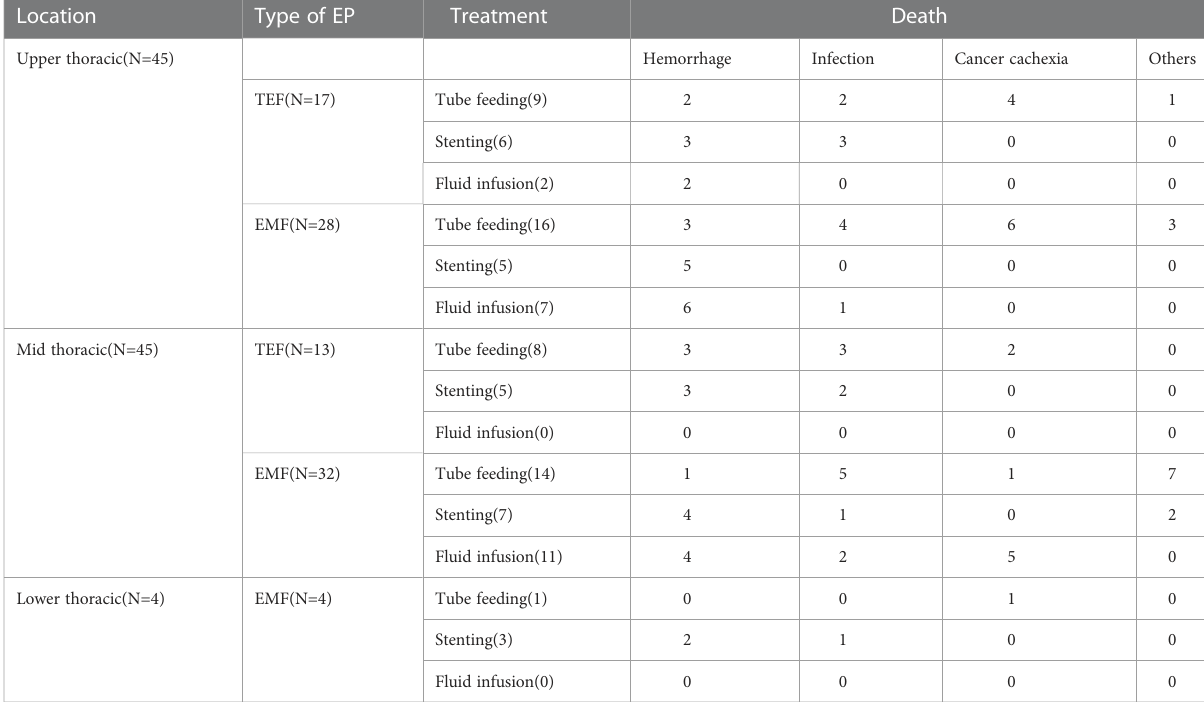
TABLE 2 The treatment after EP and causes of death for patients with upper, middle and lower thoracic EC. Location